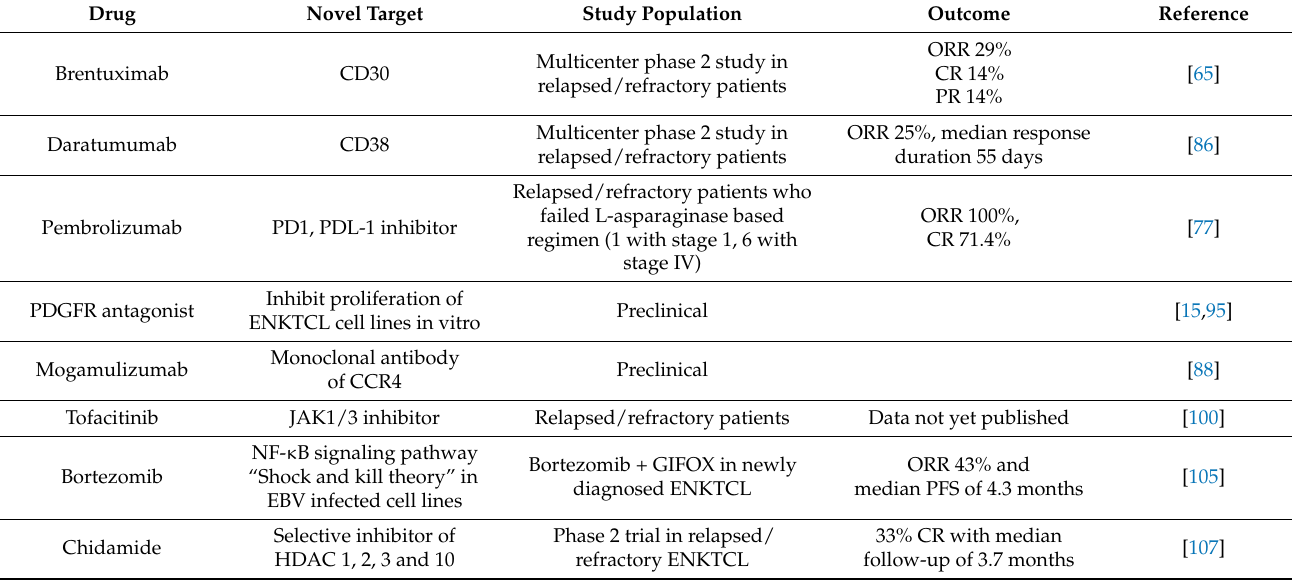
Table 2. Novel agents and their targets in the treatment of